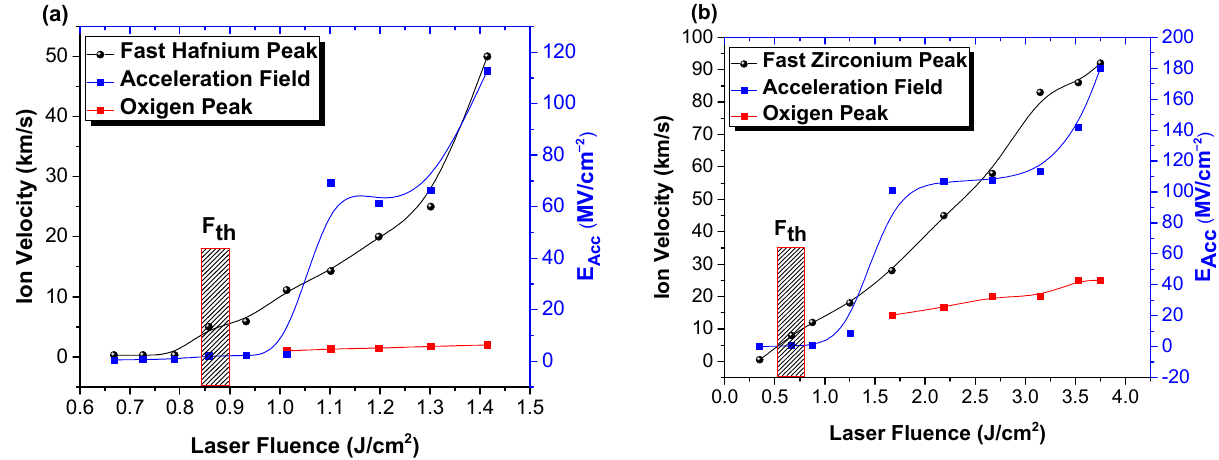
Figure 8. Ion velocities and acceleration field evolution with laser fluence for HfO 2 ( a ) and ZrO 2 ( b ).